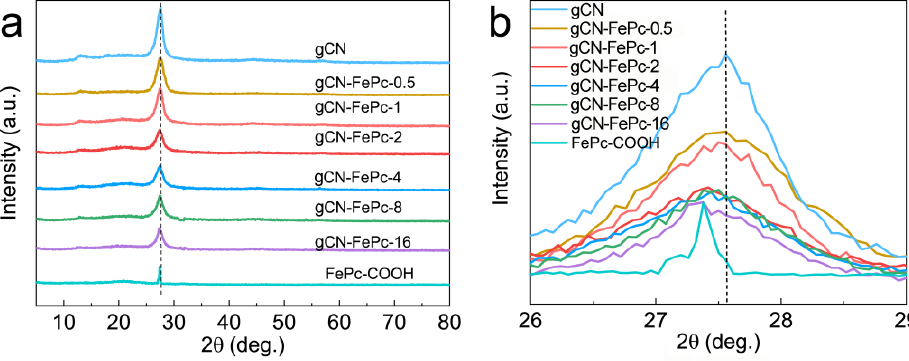
Figure 2. XRD patterns of different samples ( a ) and the enlarged region of 26 – 29° ( b